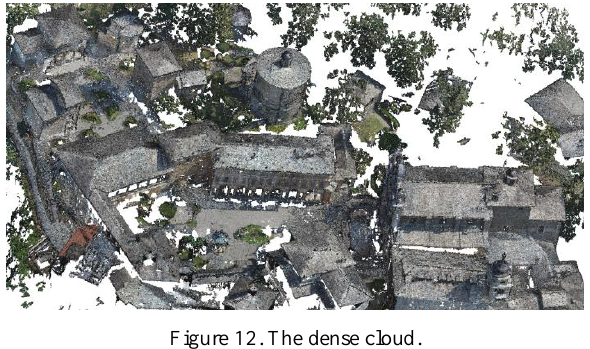
Figure 12. The dense cloud.